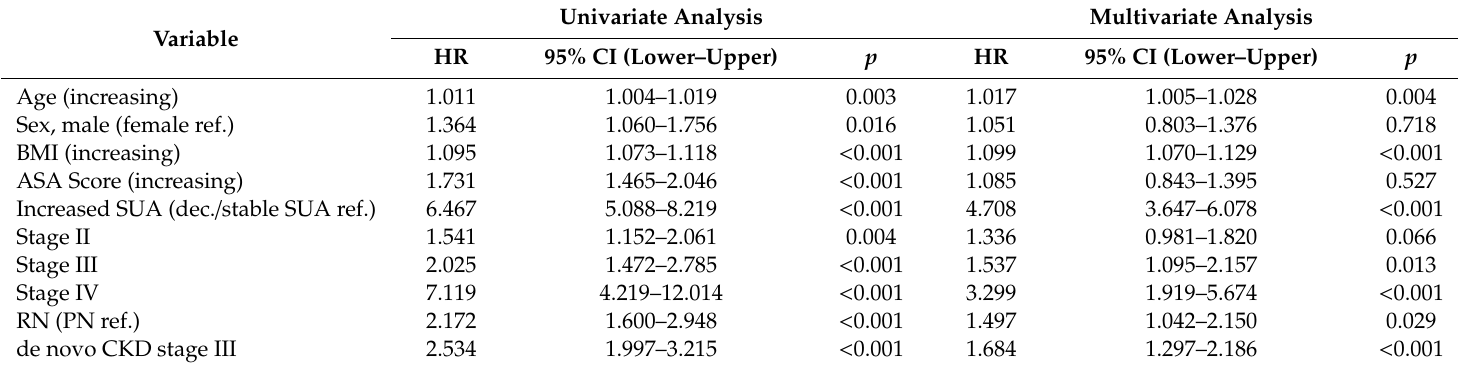
Table 5. Cox proportional hazard analysis of prognostic factors for overall survival.